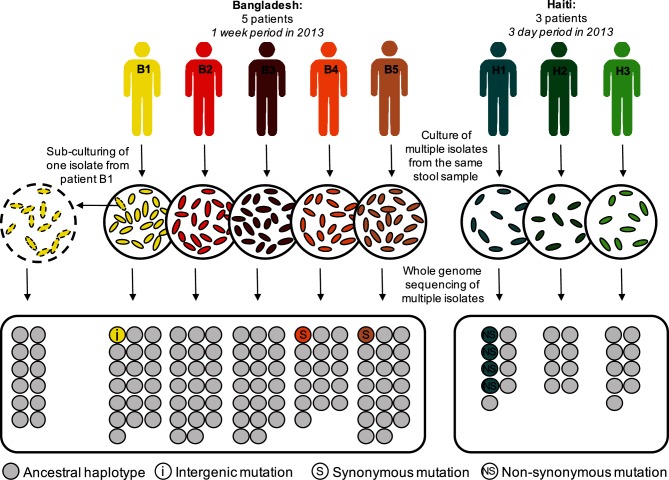
Culture and sequencing of isolates of Vibrio cholerae from eight acutely infected patients. To study within-patient evolution, selective media was used to culture stool samples from five patients from Bangladesh (B1 to B5) and three patients from Haiti (H1 to H3). Between eight and 20 colonies were isolated from each patient and sequenced separately. For patient B1, we performed a sub-culture of one isolate (dotted outline) and sequenced 12 of these new isolates as a control for cultured-induced and sequencing artefacts. We independently called variants, compared them between isolates within each patient to identify the intra single nucleotide variants (iSNVs, coloured circles) and determined whether they were intergenic (i), synonymous (S), or non-synonymous (NS) mutations.